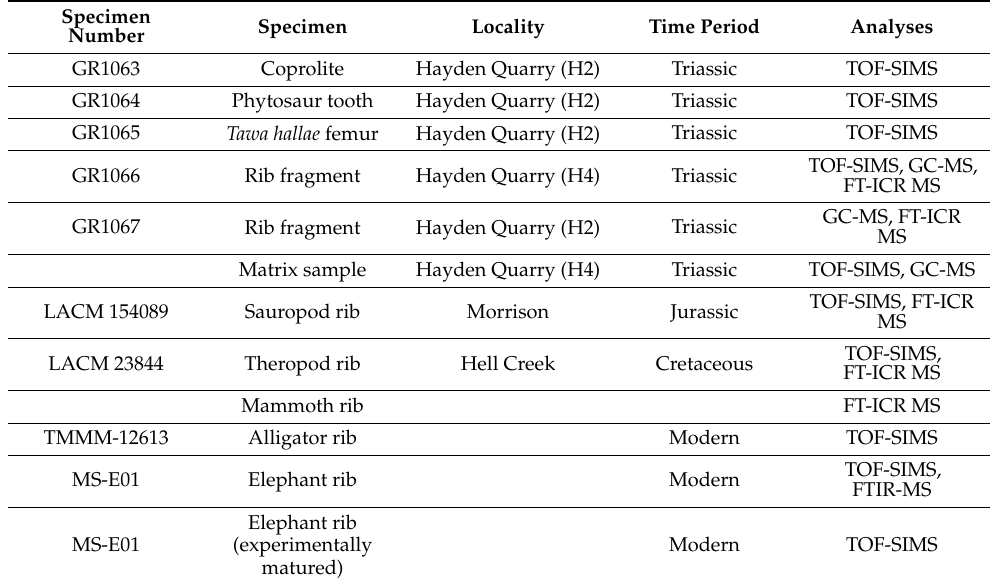
Table 1. Specimen information and analyses